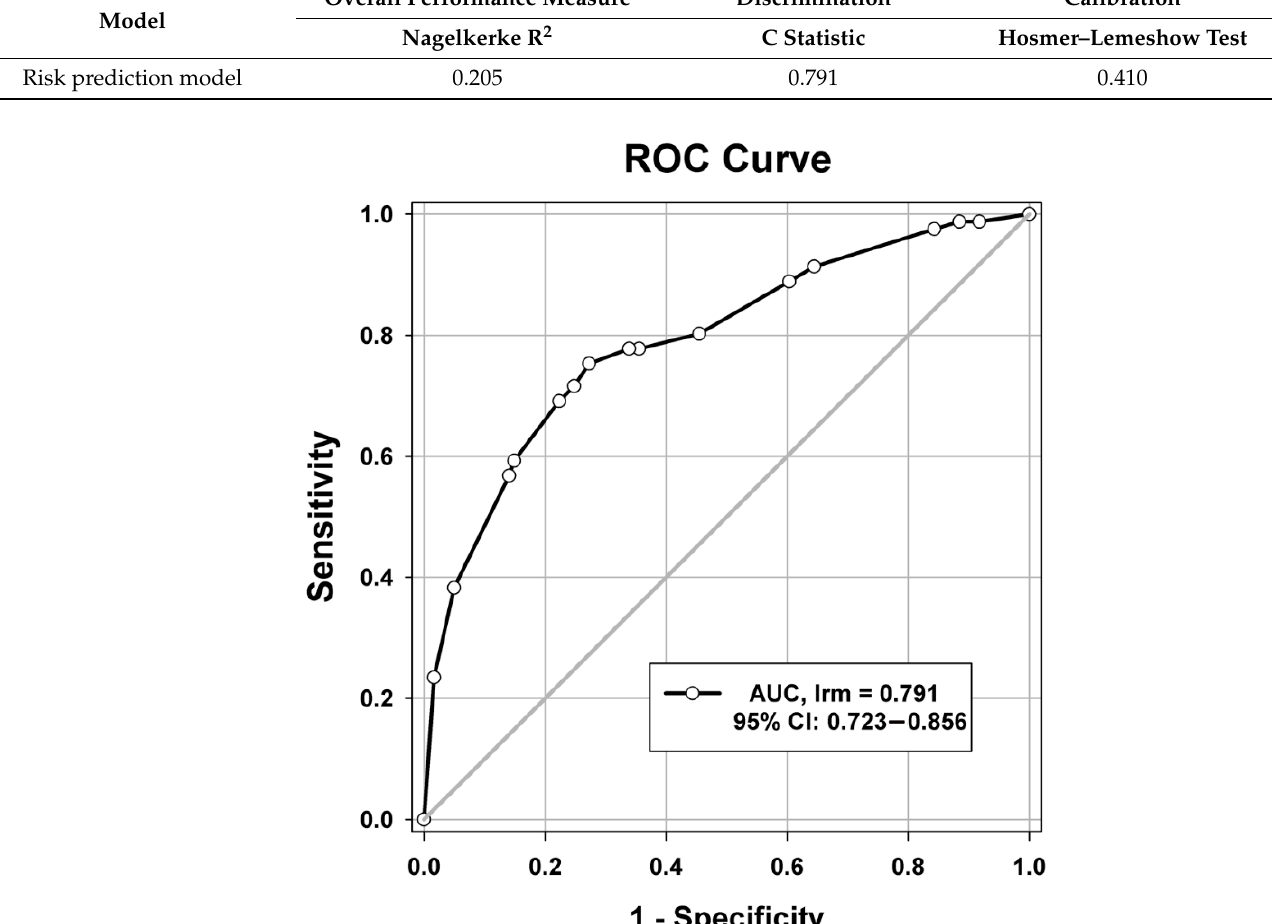
Figure 3. Receiver operating characteristic (ROC) curve analysis was used to evaluate the discrimination ability of the nomogram to predict the 6-month mortality risk. AUC, area under the ROC curve; 95% CI, 95% confidence interval.